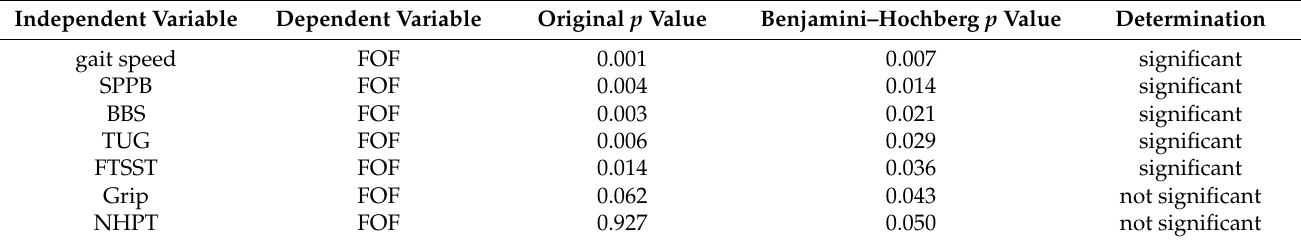
Table 2. Benjamini–Hochberg correction for multiple